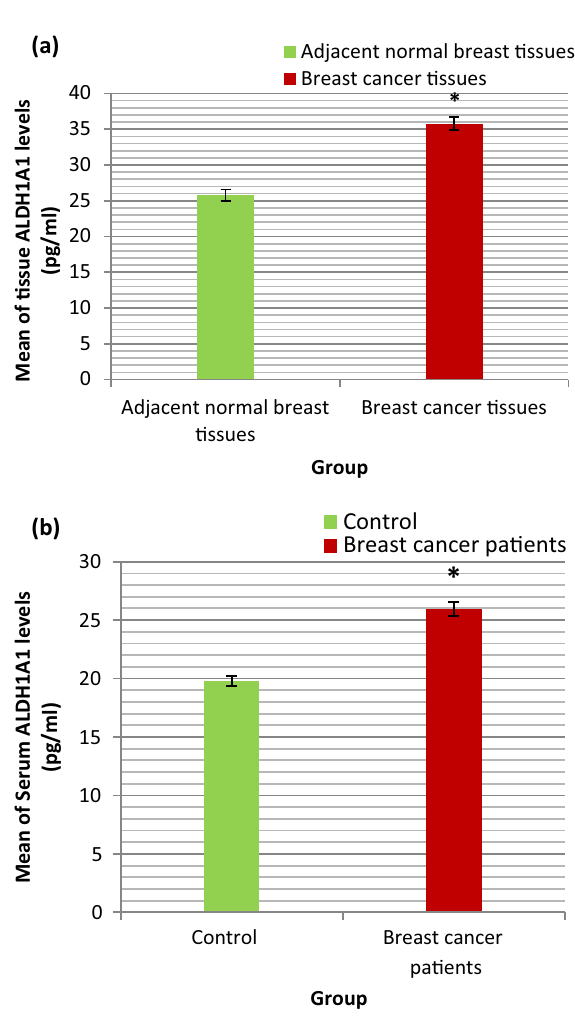
Figure 3. ( a ) Bar chart representing the mean value of ALDH1A1 (pg/ml) in BC tissues and adjacent normal breast tissues. ( b ) Bar chart representing the mean value of serum ALDH1A1 (pg/ml) in control group and BC patients group.